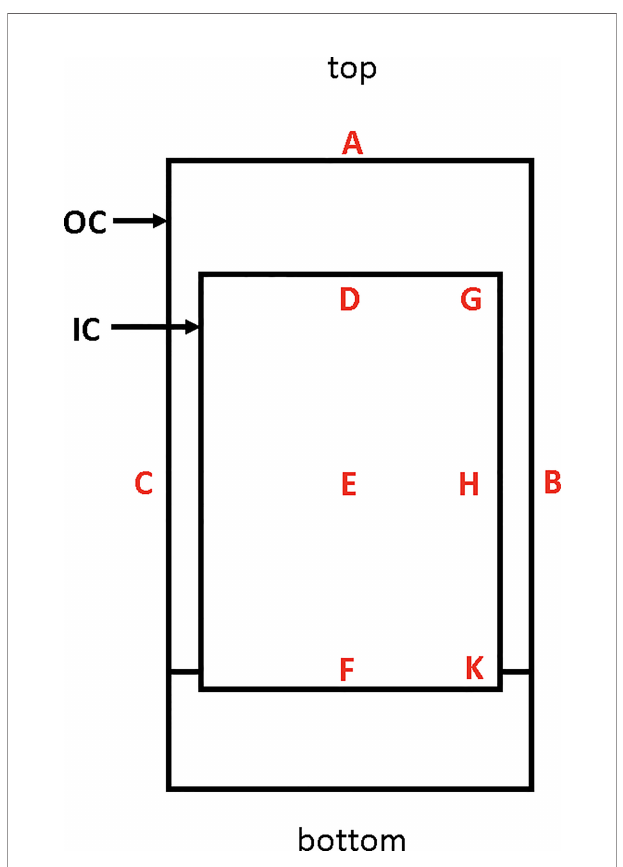
FIGURE 2 | Sagittal sectional schematic diagram of an IMTC. The inner container (IC) is housed inside the outer container (OC), which is a custom machined 1 L polycarbonate container with screw top and screw base. All nine locations used for placement of alanine transfer dosimeters for mapping are indicated. The minimum dose of irradiation was recorded at position F up to the time when a new IC was incorporated when the minimum dose location changed to D. The maximum dose location is position H. The reference dosimeter used in PfSPZ Vaccine manufacturing runs is located at position B. The relationship between the dose received at B to the dose received at D (or previously, F) and between the dose at B and the dose at H are used to generate the formulae for estimating the doses at positions D/F and H during vaccine